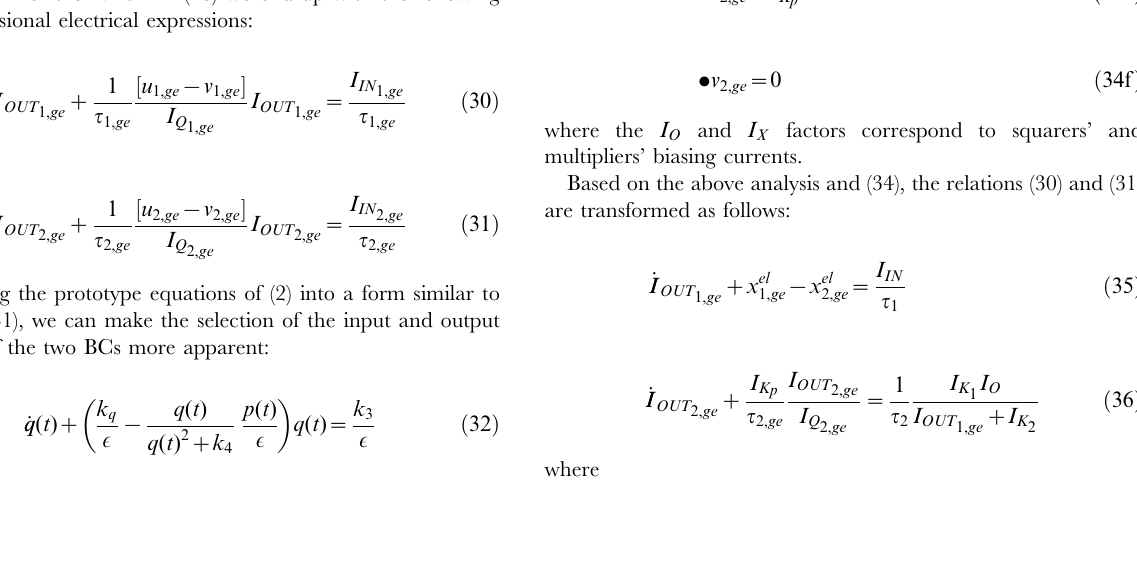
Table 1. Chemical And Electrical Equations Of The Intracellular Ca 2 z Oscillations Model ( m ~ n ~ p ~ 2 ) Case, Codified By (1), (28) & (29).